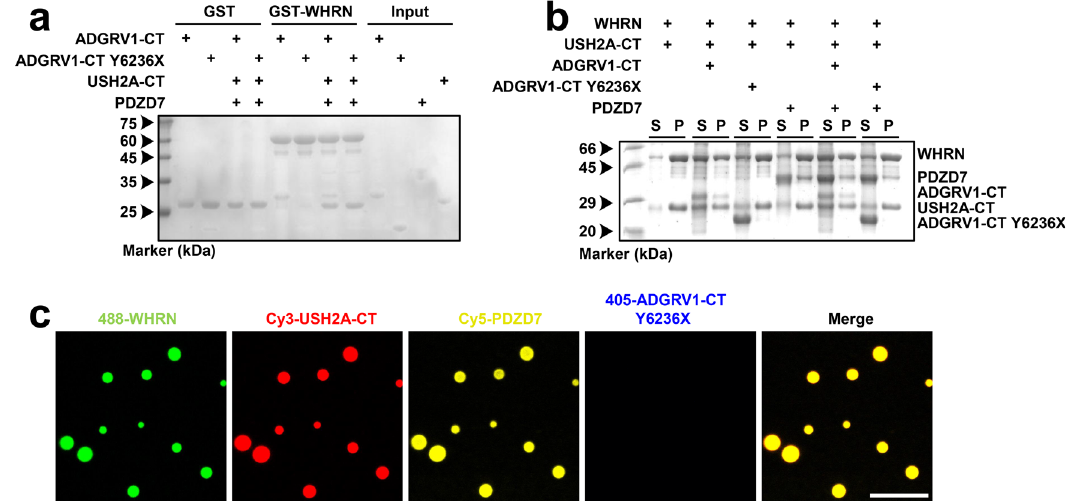
Fig.9|Deafness-relatedmutationonADGRV1-CTaffectstheLLPScapacitiesof USH2 proteins. a GST pull-down assay showing that though the pulled-down USH2A-CT and PDZD7 remained unaffected, ADGRV1-CT Y6236X was not pulled down by GST-WHRN and the assembly of quaternary USH2 protein complex was disrupted. b Co-sedimentation assay showing that ADGRV1-CT Y6236X was not enriched in the protein pellets, and the protein pellet enrichments of WHRN,